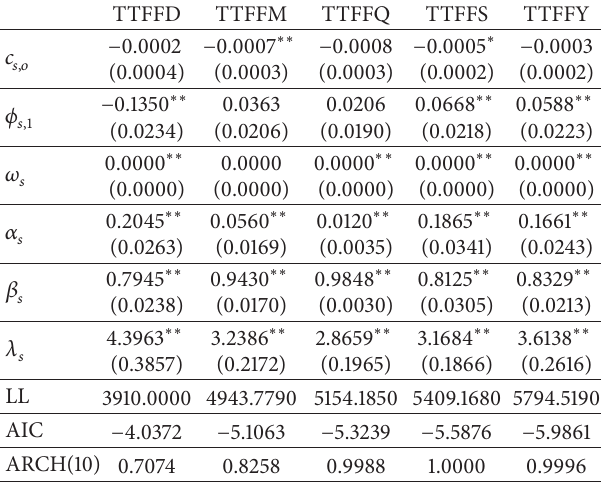
Table 2: Estimated parameters of agricultural commodity returns for marginal model.